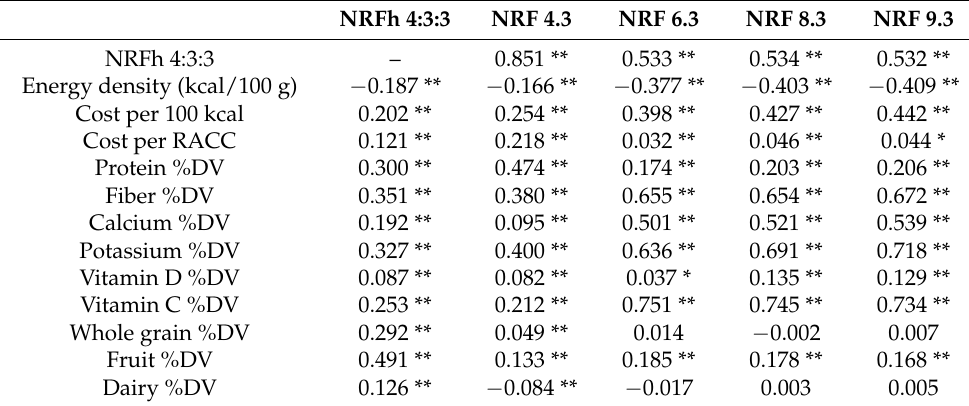
Table 3. Correlations between NRFh 4:3:3 and NRF n.3 energy density, and food components expressed as %DV.